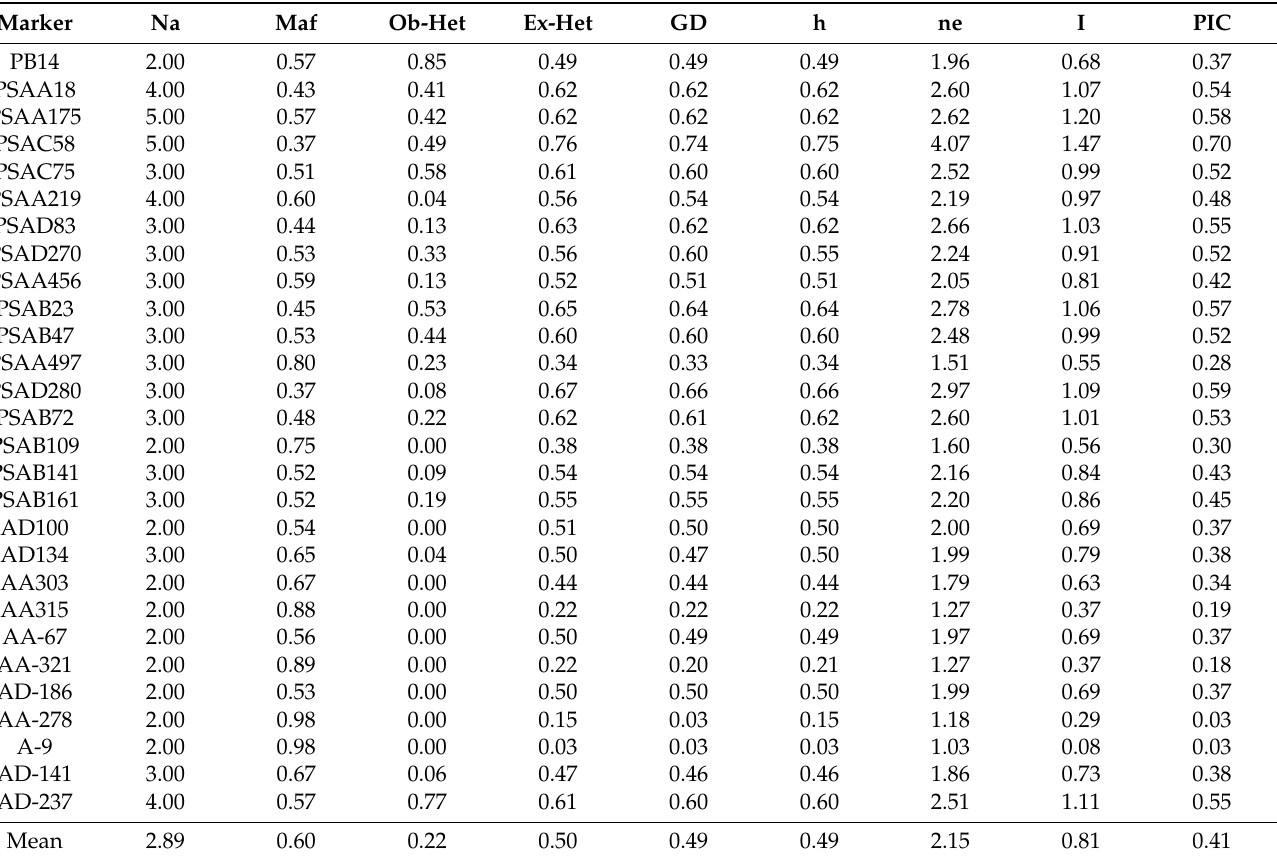
Table 3. Genetic diversity indices of forage pea ( P. sativum ssp. arvense L.) landrace